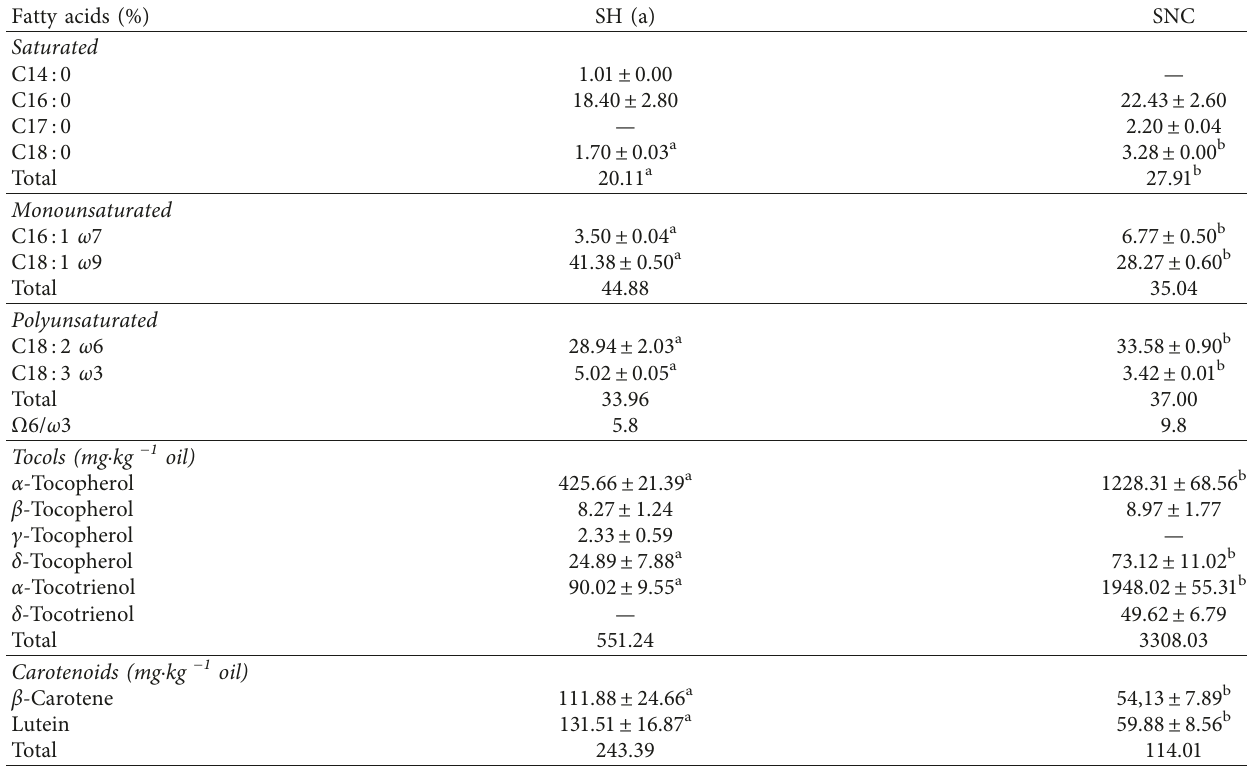
Table 2: Profile of fatty acids expressed as methyl esters (%) and content of tocols and carotenoids present in the waste seed of avocado SH and SNC varieties.